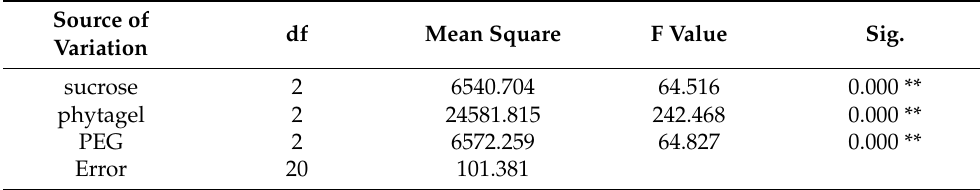
Table 2. Analysis of variance (ANOVA) of effect of sucrose, gellan gum (phytagel) and PEG on